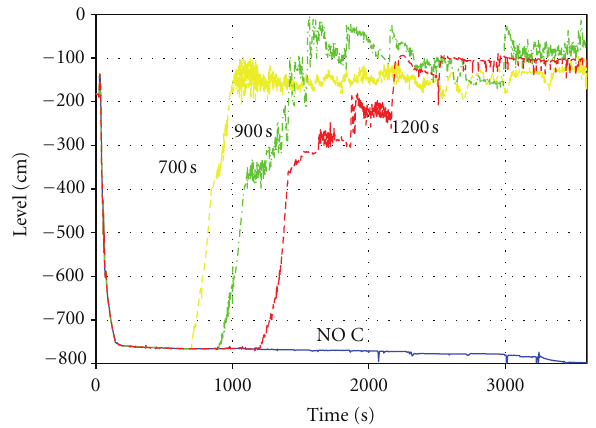
Figure 4: Level respect to top of active fuel (TAF) or fuel zone. HPCS injection to 700 s, 900 s, and 1200 s; NO C indicates without HPCS injection.